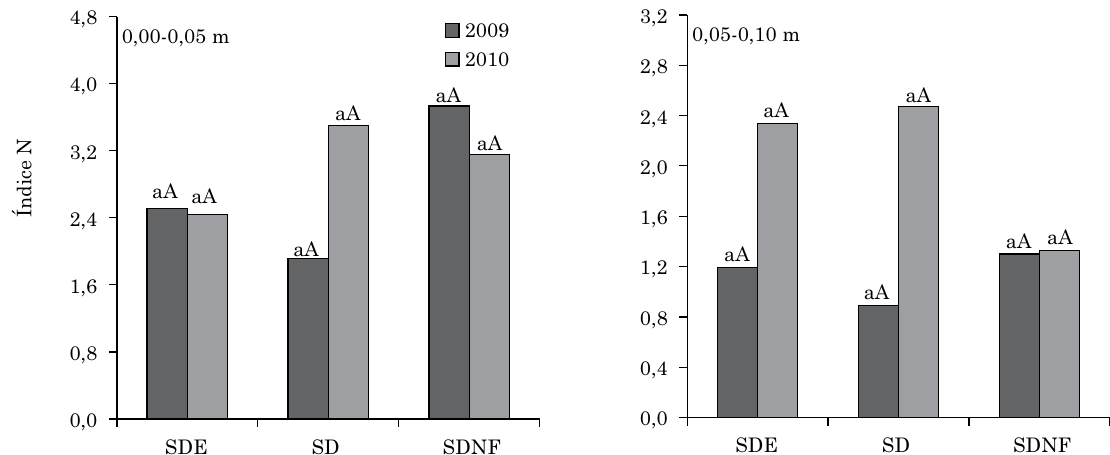
Figura 4. Valores médios do parâmetro N obtidos do modelo: log K a = log M + N log ε a para os tratamentos semeadura direta escarificada (SDE), semeadura direta (SD) e semeadura direta cultivada com nabo forrageiro (SDNF) nas camadas 0,00-0,05 e 0,05-0,10 m na cama de semeadura do milho (2009) e da soja (2010). Barras seguidas de mesma letra minúscula indicam que as médias entre tratamentos em cada ano para cada profundidade não diferem pelo teste Tukey a 5 %, e seguidas de mesma letra maiúscula as médias entre os anos para cada tratamento e cada profundidade não diferem pelo teste Tukey a 5 %.